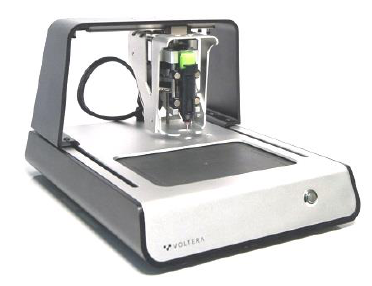
Fig. 1. Appearance of the Voltera V-One Printer.